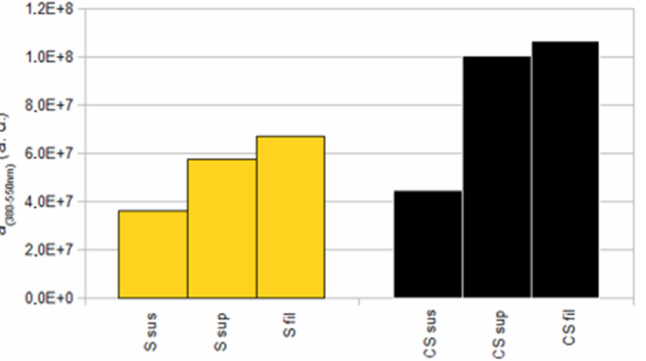
Figure 10. Value of the area below the emission curve between 380-550 nm for 5-[Mn III ] 4.6 @SNP (4.6 × 10 − 7 mol/L) (S—yellow) and 5-[Mn III ] 4.2 @CSNP (5.1 × 10 − 7 mol/L) (CS—black). sus: sus- pension; sup: supernatant; fil: